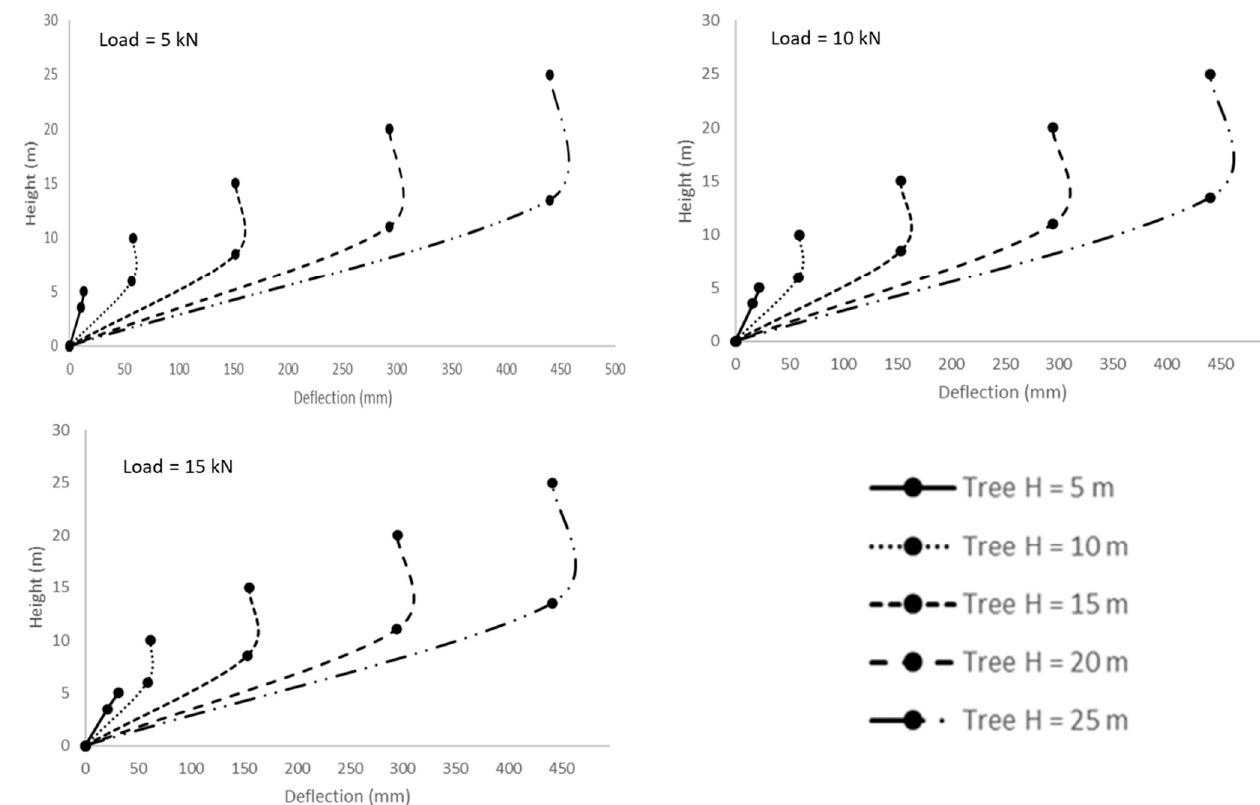
Figure 3. Behavior variation of the deflection (mm) versus tree height (m) for scenario 1 (slenderness 22; taper 0.030) and for the simulated horizontal forces (5 kN, 10 kN, and 15 kN).